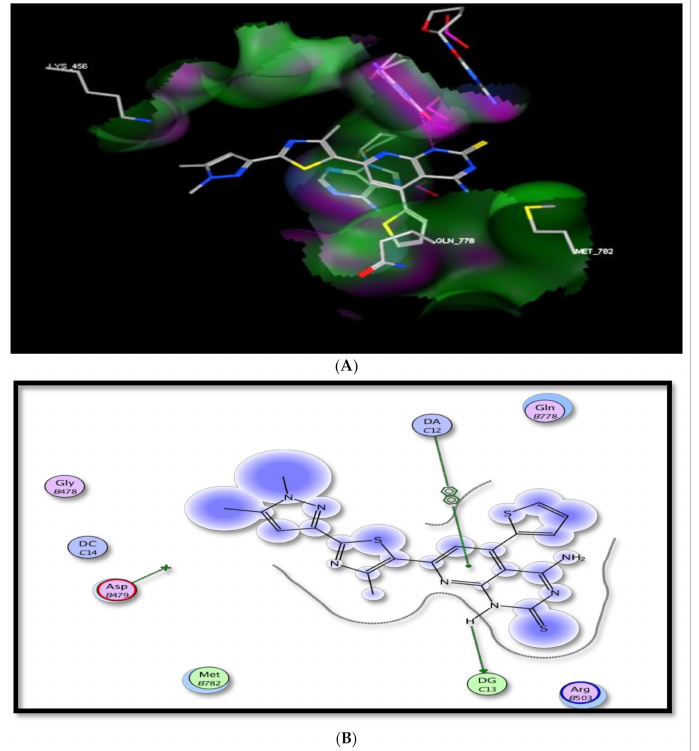
Figure 11. The suggested binding mode of compound 13 within topoisomerase II. ( A ) 3D binding mode within the active site. ( B ) 2D binding mode within topoisomerase